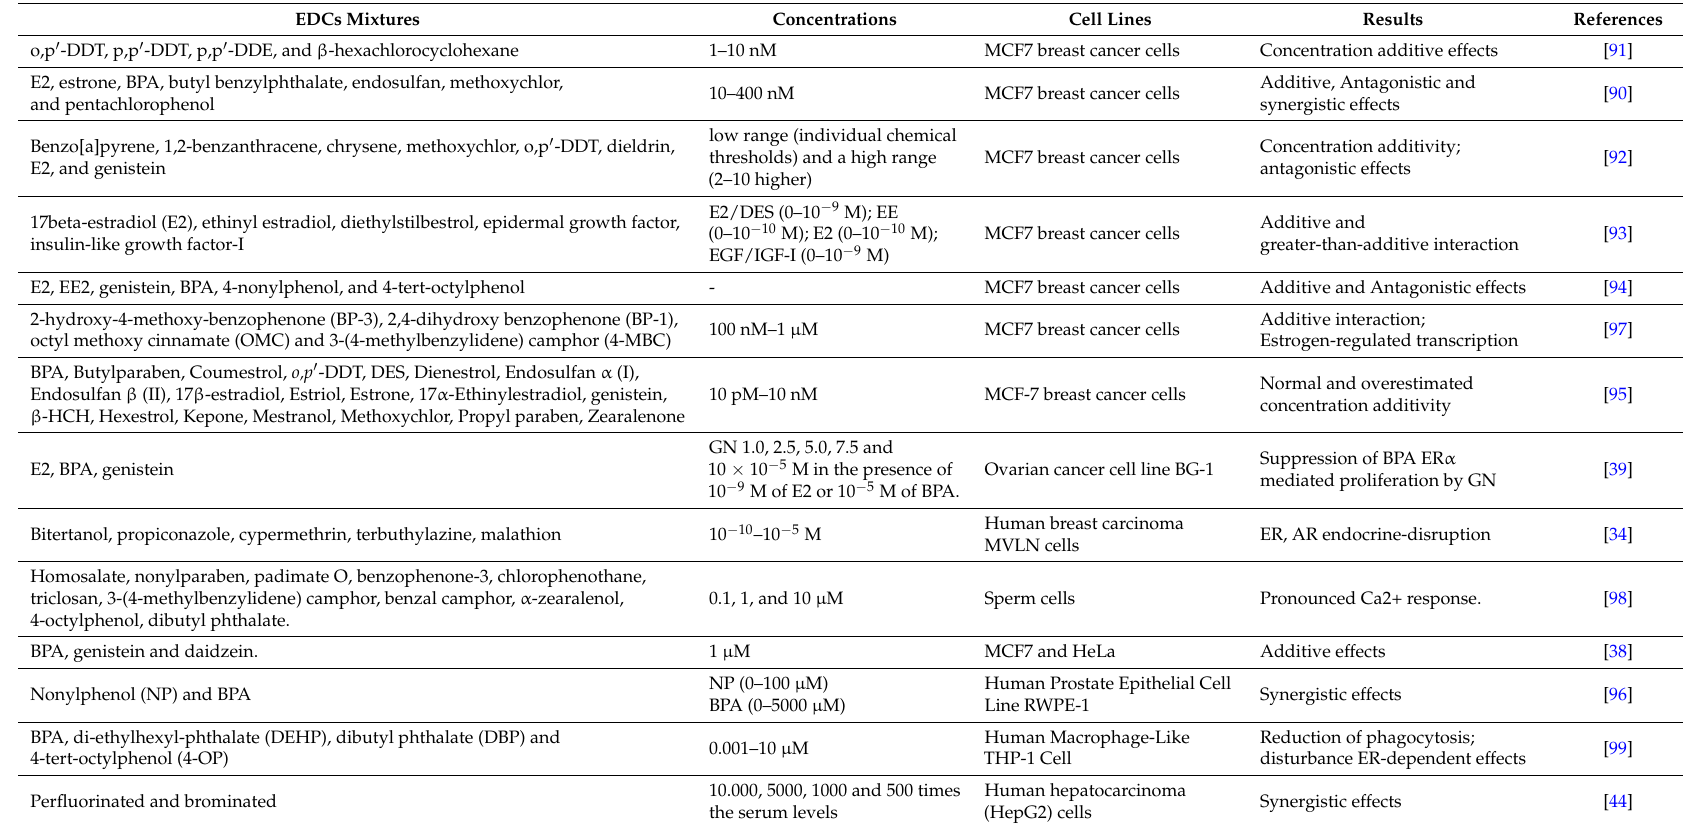
Table 1. Effect of EDCs mixtures in human cell